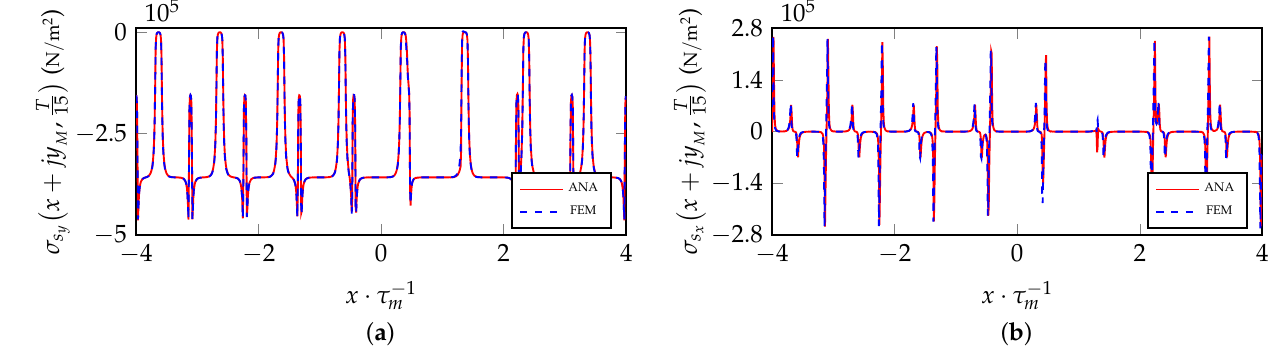
Figure 14. Analytical and FEM no load Maxwell tensor distributions on the middle mechanical air-gap line of the slotted machine of Figure 5a, with PM slider position corresponding to a time